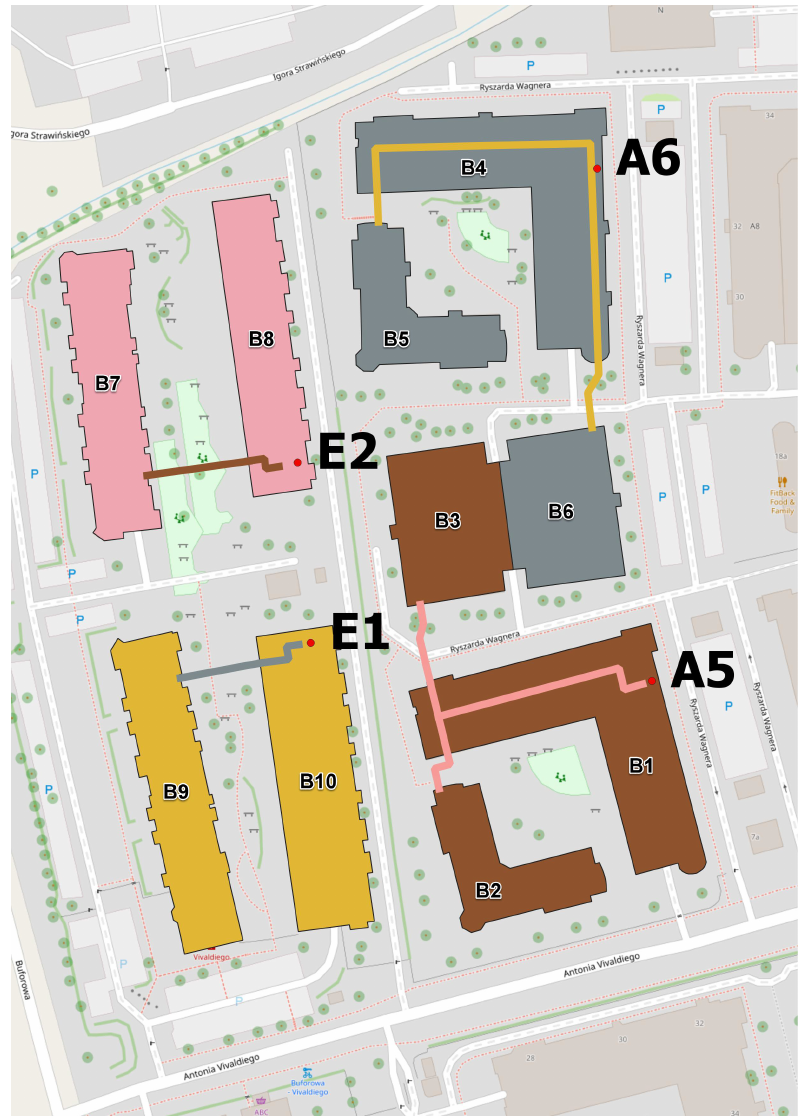
Figure 2. A technological diagram of the research